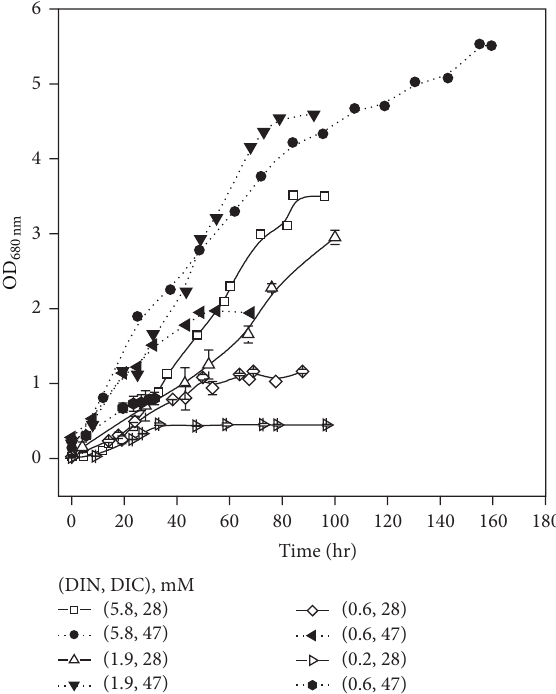
Figure 3: Growth curves under various DIC and DIN concentra- tions in a batch